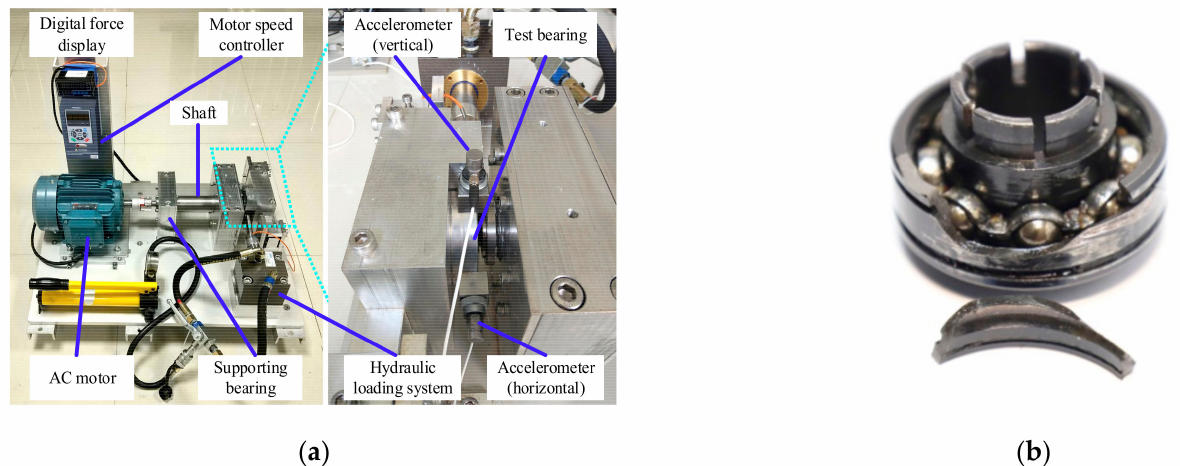
Figure 3. Bearing accelerated life test bed and outer–ring crack of bearing. ( a ) Bearing accelerated life test bed. ( b ) Outer–ring crack of